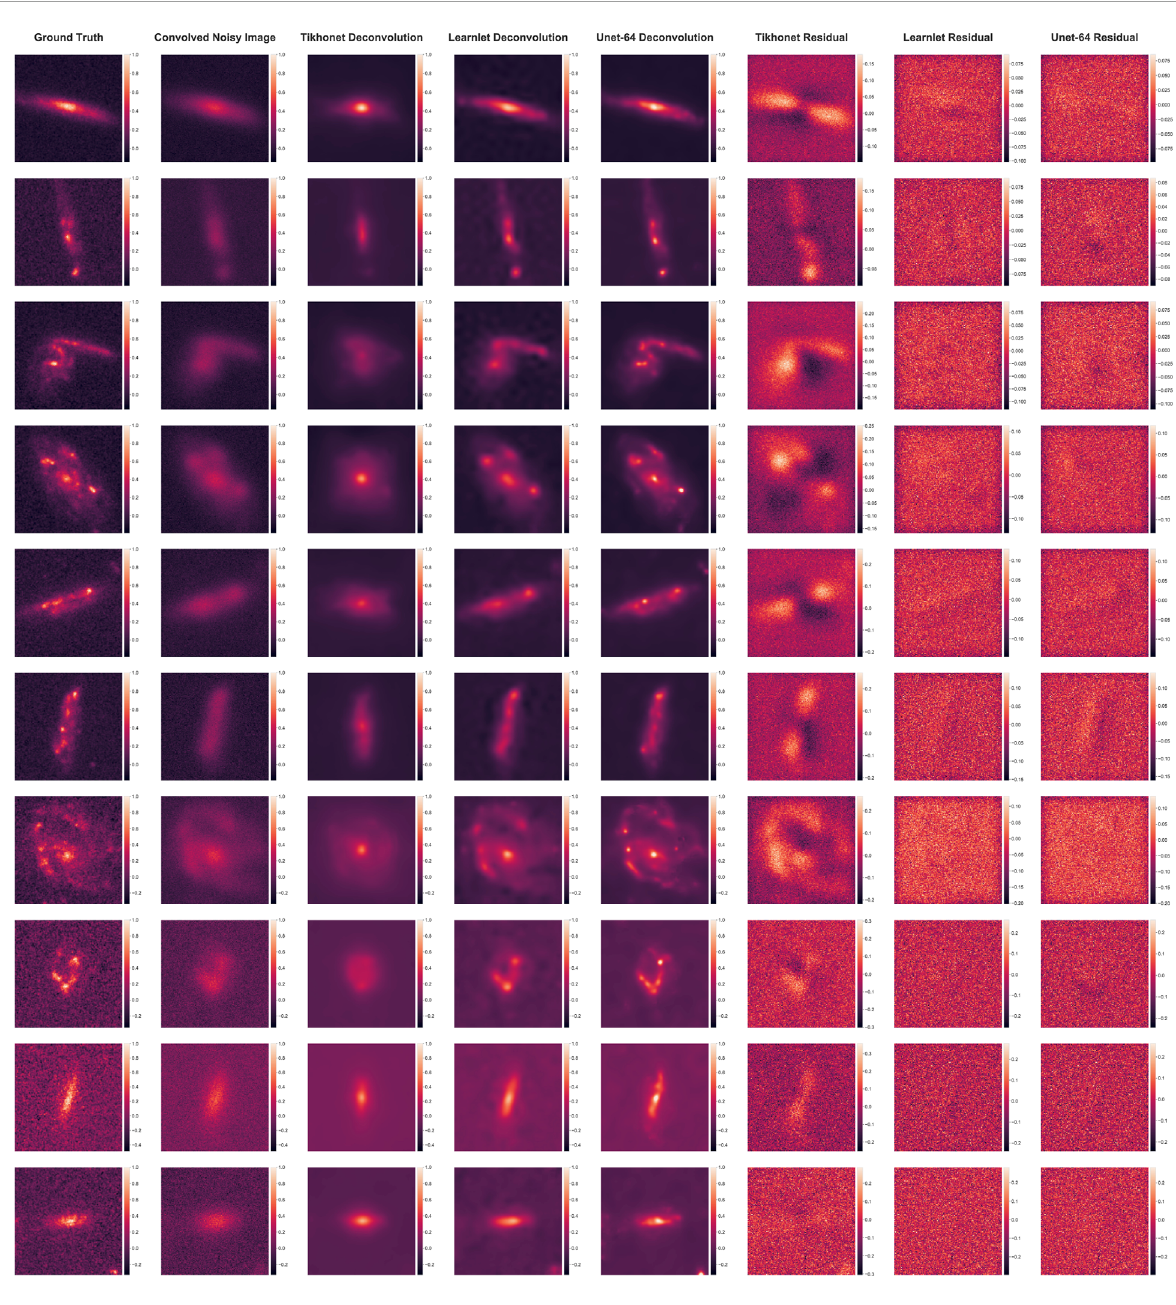
small objects but is unable generalize well to extended